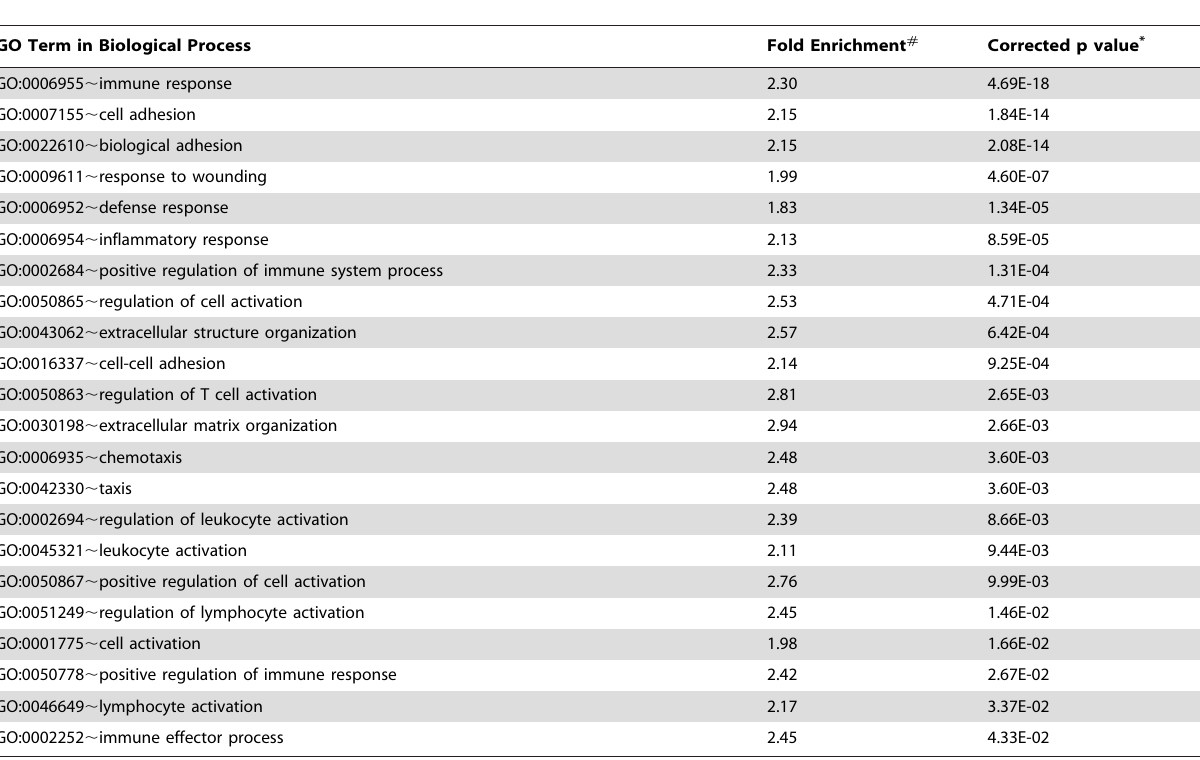
Table 2. Gene Ontology terms of enriched differentially expressed genes in bladder cancer.